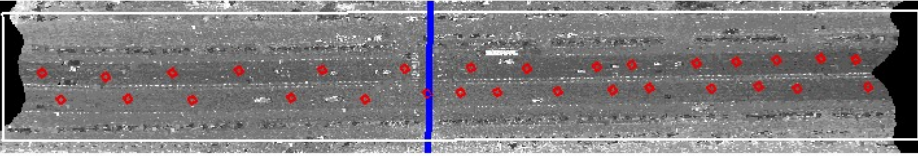
Figure 5. Sampling areas in flight strip 2.